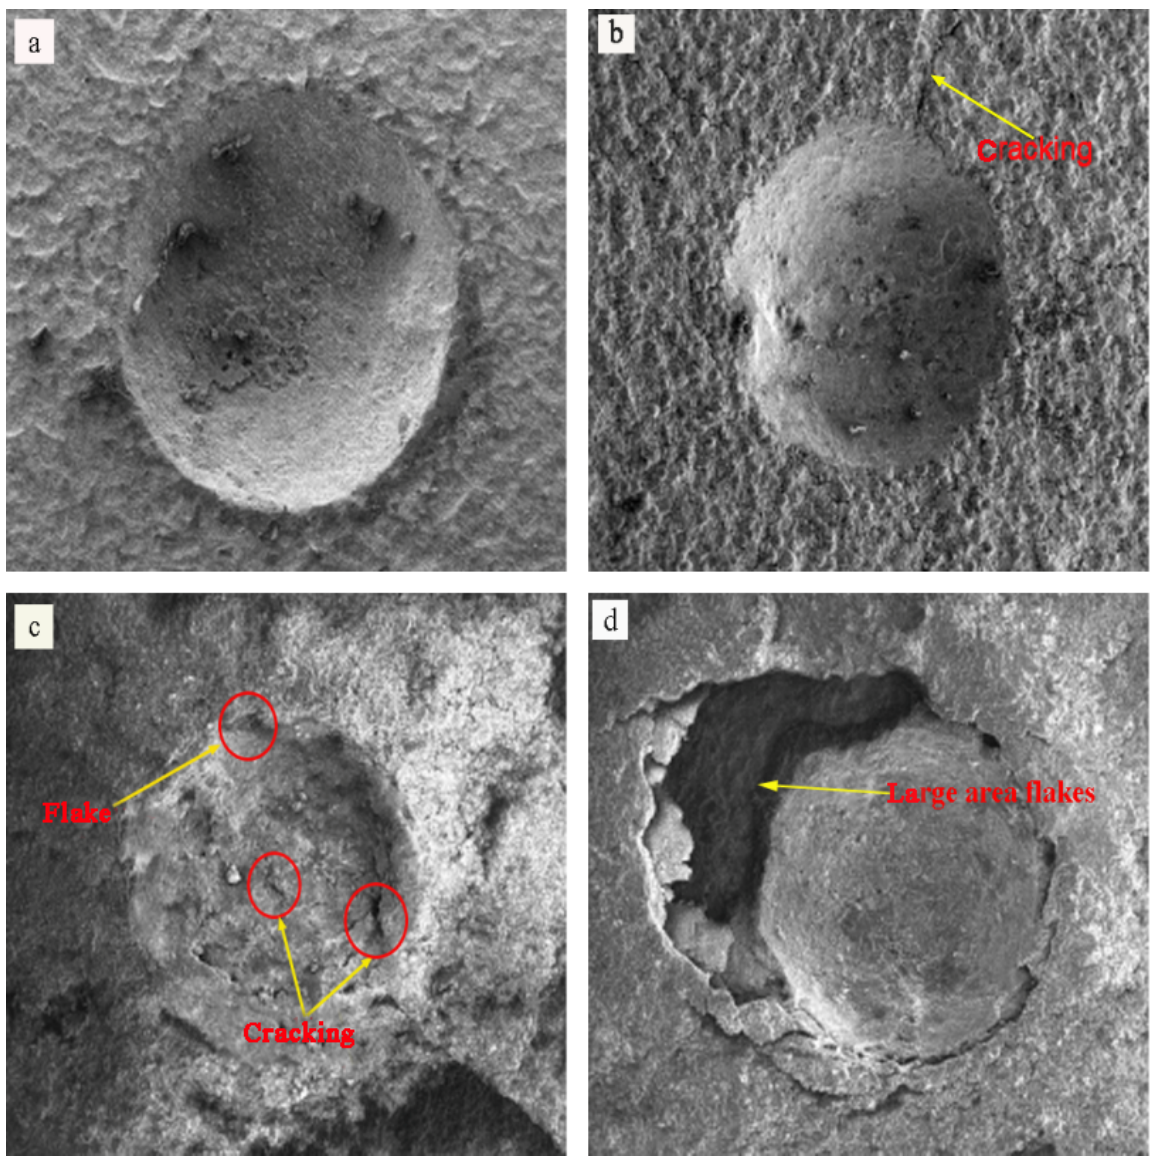
Figure 3: The surface morphology of indentation: (a)Substrate; (b)NiCr coating; (c)Al 2 O 3 coating with the undercoating of NiCr; (d)Al 2 O 3